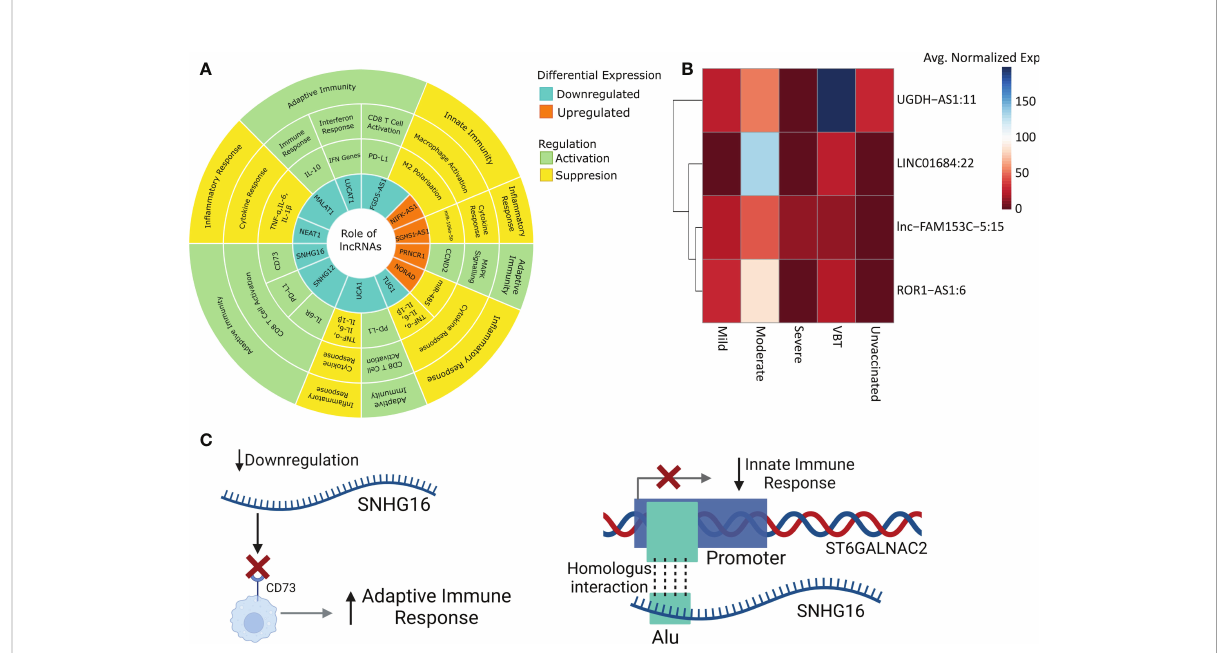
FIGURE 7 Summary and possible mechanism of the lncRNA functions. (A) Summary of the lncRNA functions, represented with respect to the VBT group. (B) Average normalized expression of selected lncRNAs across two study cohort. (C) Mechanisms of lncRNA-mediated immune modulation, taking SNHG16 as an